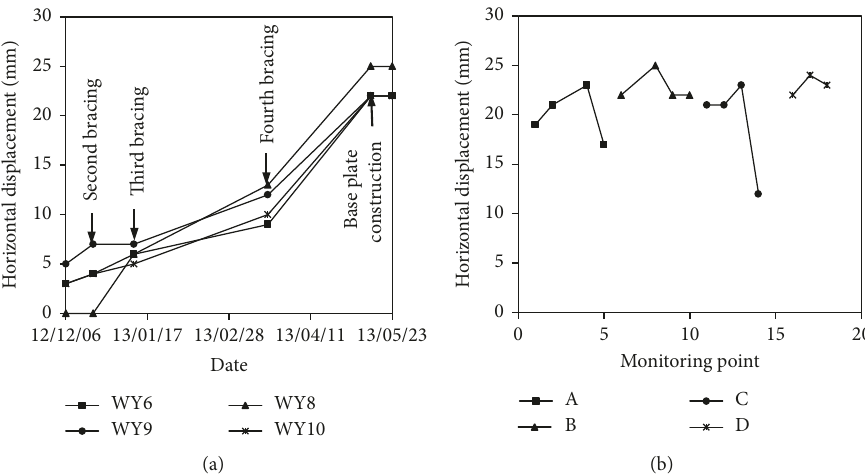
Figure 5: Horizontal displacement of diaphragm wall top at B side. (a) Time curves of diaphragm wall top at B side. (b) Curves when finishing base plate construction.